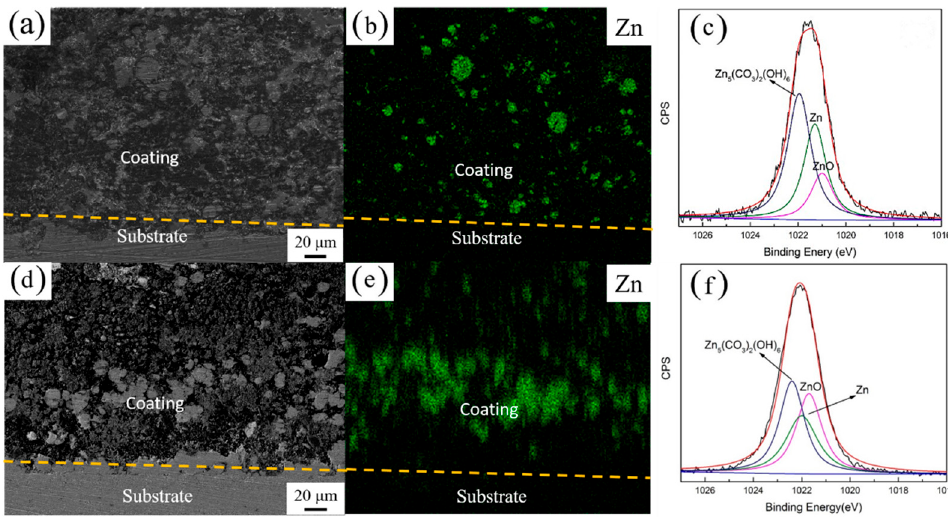
Figure 3. The cross sectional SEM images and Zn 2p3/2 high-resolution XPS spectrum for the coated samples ( a – c ) ZRPs and ( d – f ) Gr0.6-ZRPs after immersion in a 3 wt. % NaCl solution for 25 days.